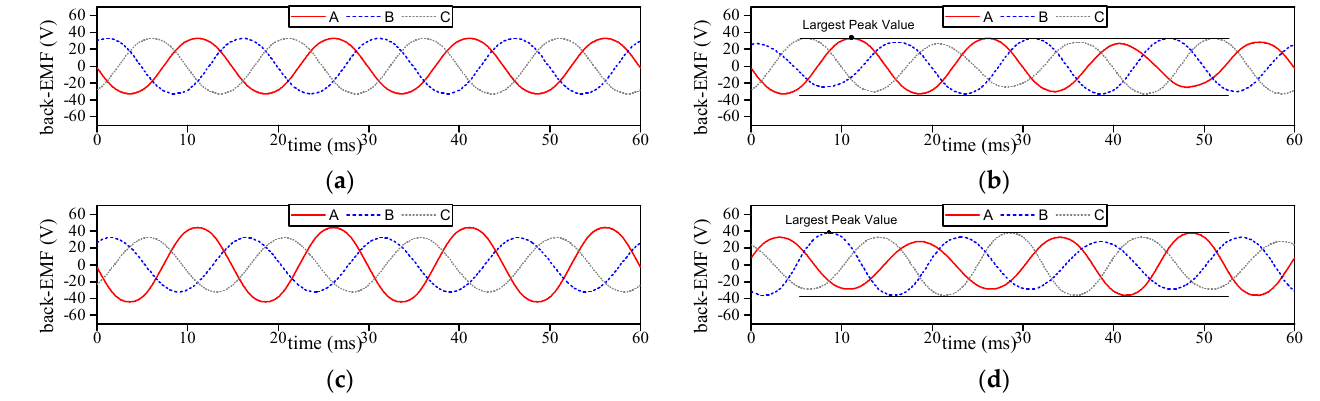
Figure 15. Simulated three − phase back − EMFs for 9 − slot and 8 − pole PMSM at 1000 rpm. ( a ) Healthy condition; ( b ) partial demagnetization fault; ( c ) static eccentricity fault; ( d ) dynamic eccentricity fault.